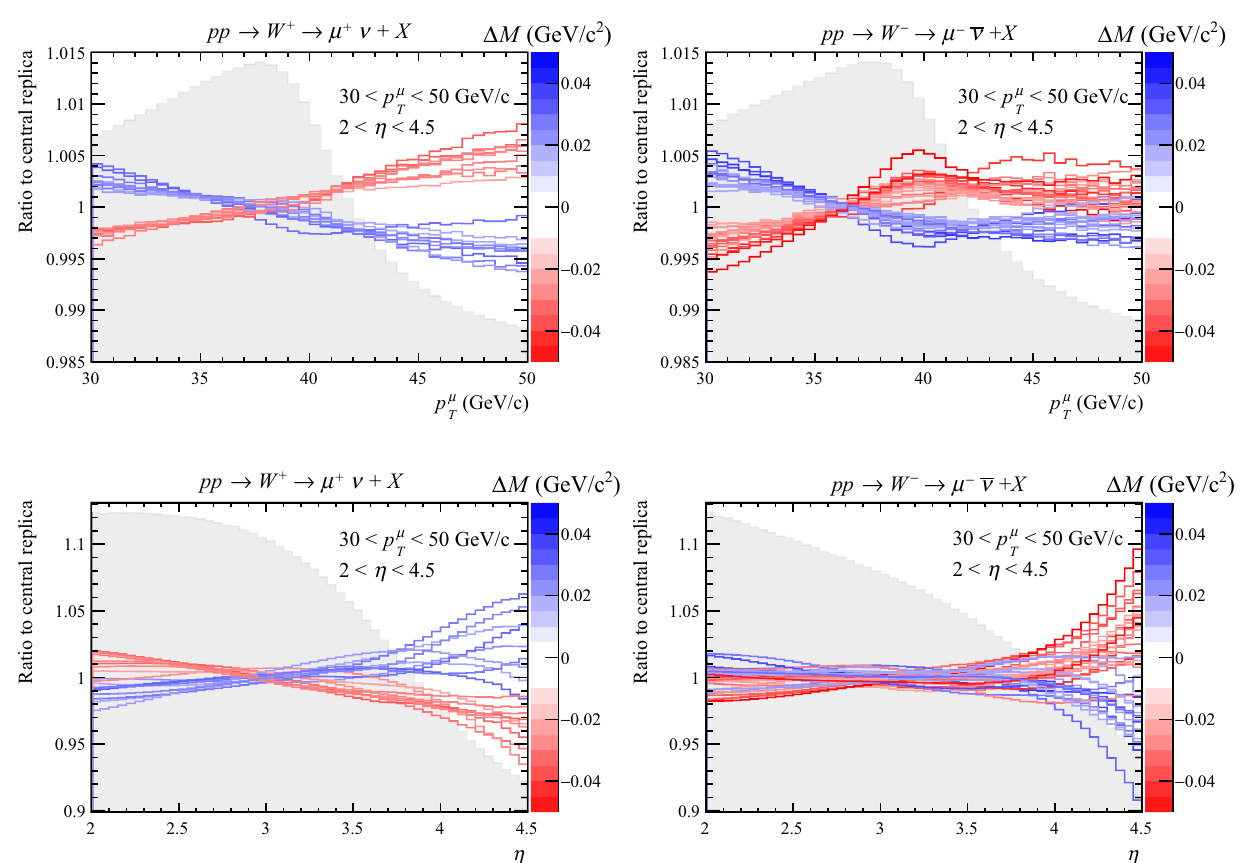
μ μ the p and η distributions pre- distribution of a single toy dataset. For clarity, the replicas for T T which the shift in M W is close to zero are not drawn